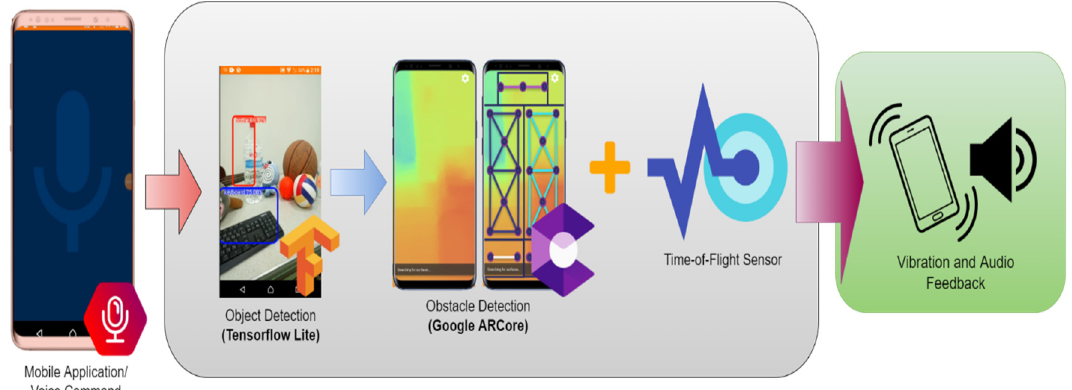
Figure 1. The proposed system workflow mobile application using voice command ( left ), mobile application interface and features ( middle ), and feedback to users ( right ).